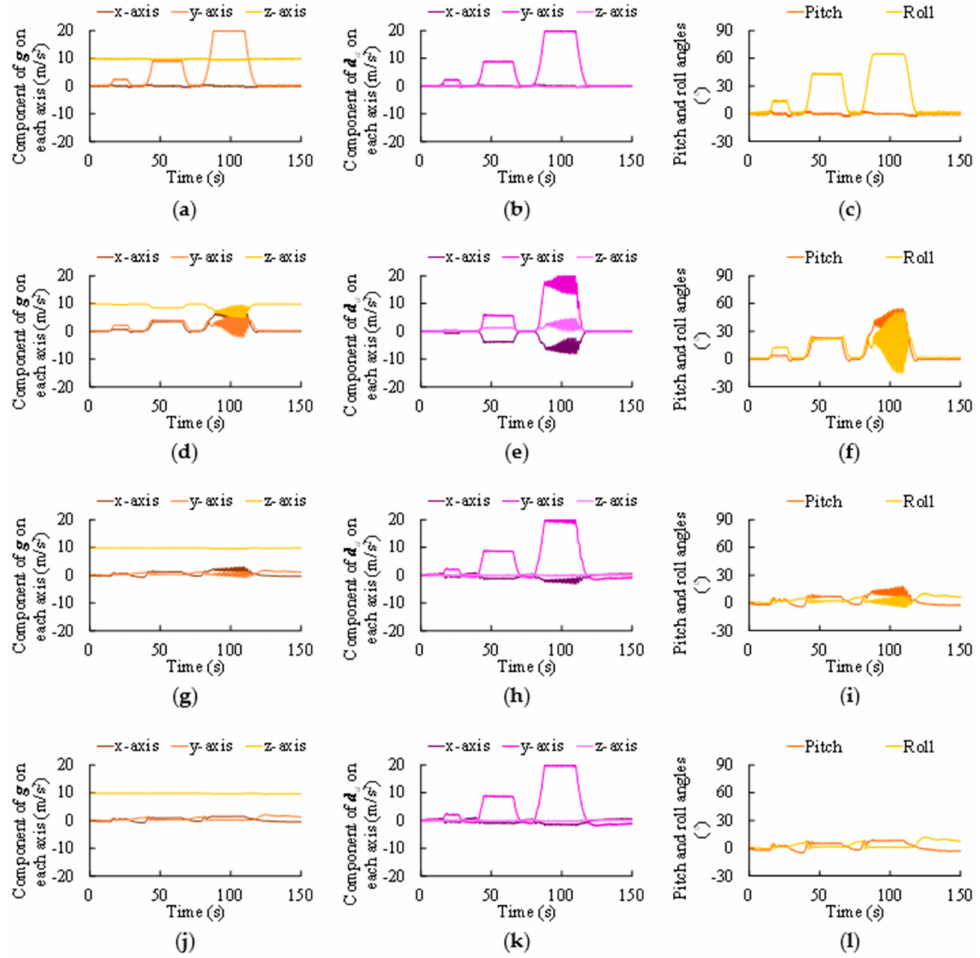
Figure 6. Estimation of gravity vector g and disturbance d a , as well as the corresponding pitch ( θ ) and roll ( ϕ ) angles. ( a ) g measurements, with uncompensated d a . ( b ) Theoretical value of d a . ( c ) θ and ϕ calculated from uncompensated g measurements. ( d ) g estimated by PA-KF with c estimated by PA-KF. ( f ) θ and ϕ calculated from PA-KF outputs. ( g ) g estimated by PM-KF with c a = 0.92. ( h ) d a estimated by PM-KF. ( i ) θ and ϕ calculated from PM-KF outputs. ( j ) g estimated by PM-CF with c a = 0.93. ( k ) d a estimated by PM-CF. ( l ) θ and ϕ calculated from PM-CF